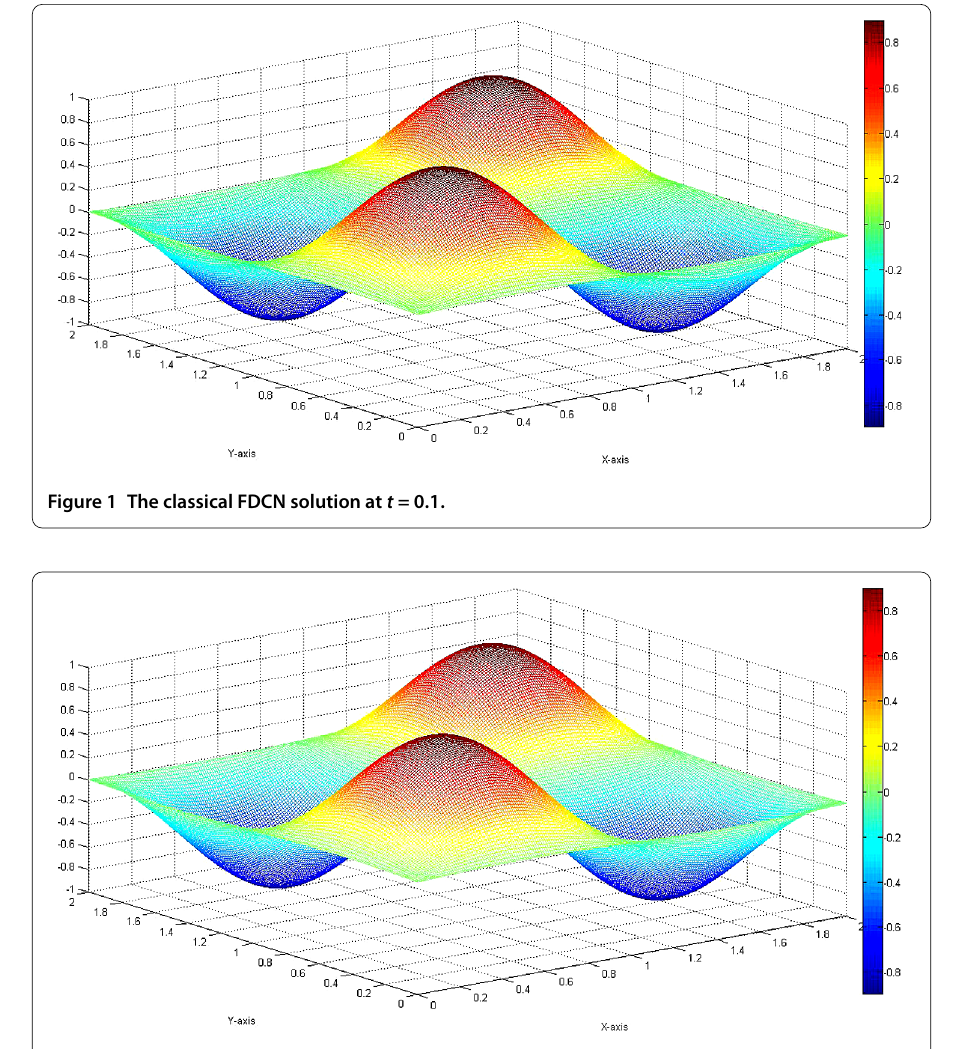
Figure 2 The OFDCNI solution at t =